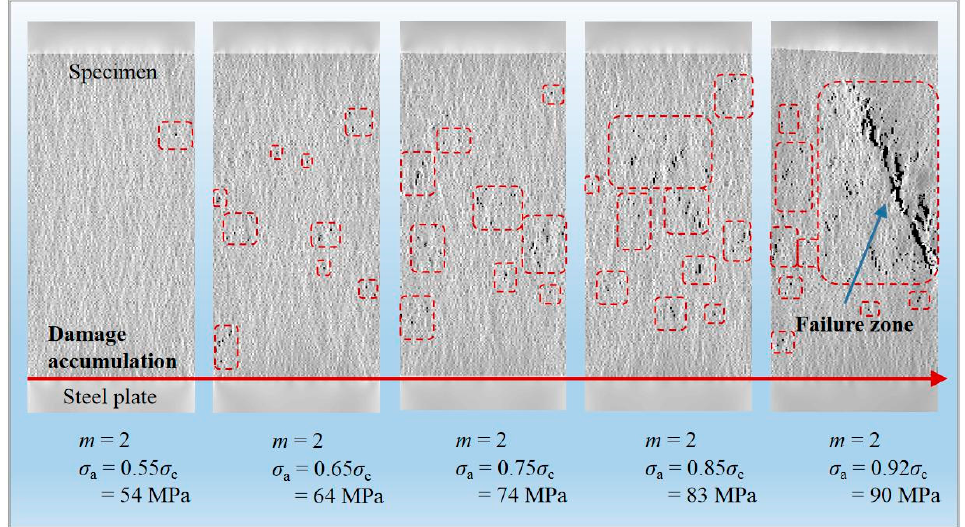
Figure 17. Damage accumulation for the constant homogeneity index ( m = 2) during uniaxial creep loading.